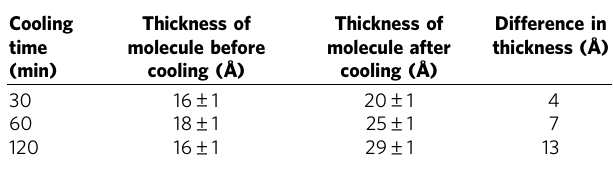
Figure 4 | Schematic structure of a GaN-based magnetless Hall device. A two-dimensional electron gas is formed between the AlGaN layer and the GaN layer underneath it. Current flows between two electrodes and the Hall voltage is measured between the transverse set of electrodes. Nanoparticles are attached to the substrate through chiral molecules (in this case, oligopeptides) adsorbed on top of the conductive